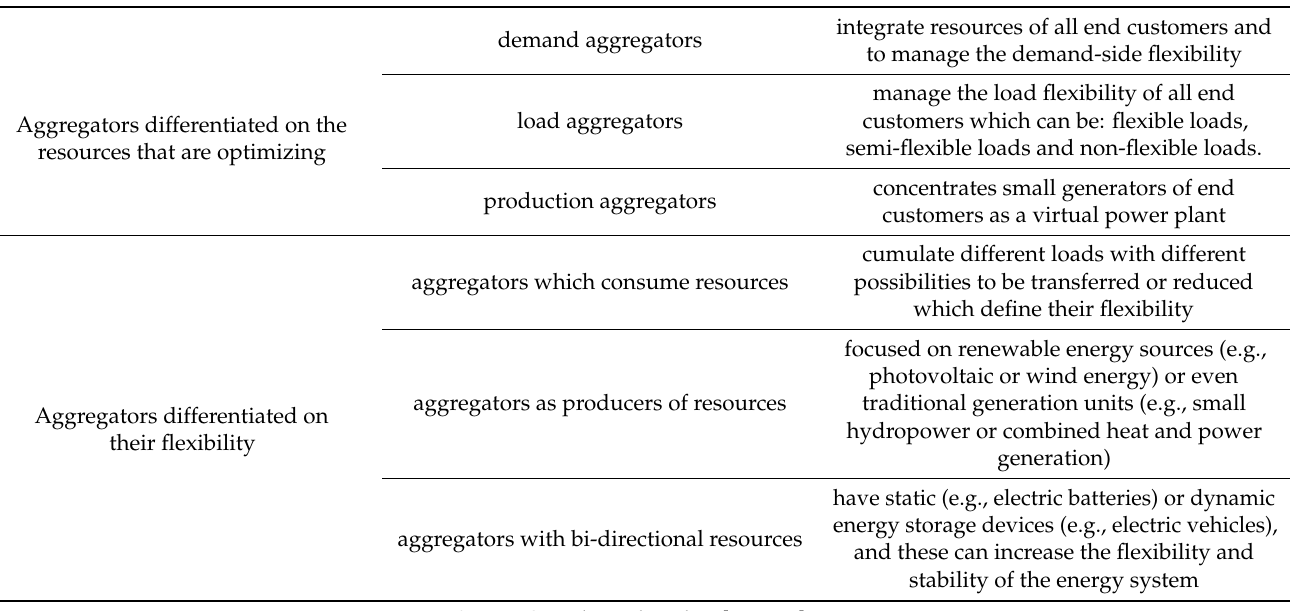
Table 1. Classification of